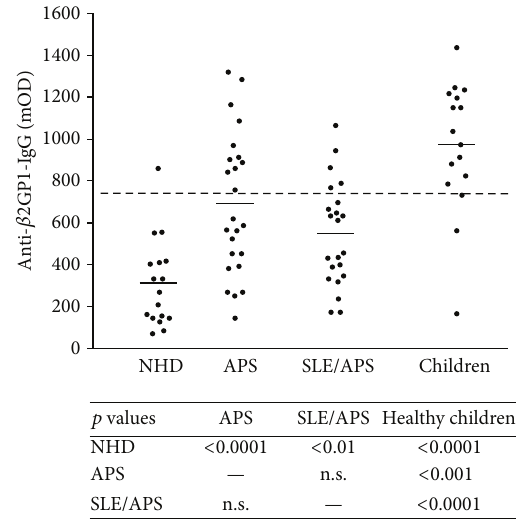
Figure 1: Total anti- 𝛽 2GP1 IgG in the sera of NHD, PAPS, SLE/APS, and healthy children and the corresponding 𝑝 values. NHD showed significantly lower mOD values than all other cohorts whereas healthy children represented the highest mOD values. Short horizontal lines: mean mOD values of all samples of the cohort. Long broken line: 97.5% quantile of NHD (=738 mOD); NHD = normal healthy donor; PAPS = primary antiphospholipid syndrome; SLE/APS = antiphospholipid syndrome with systemic lupus erythematosus; OD = optical